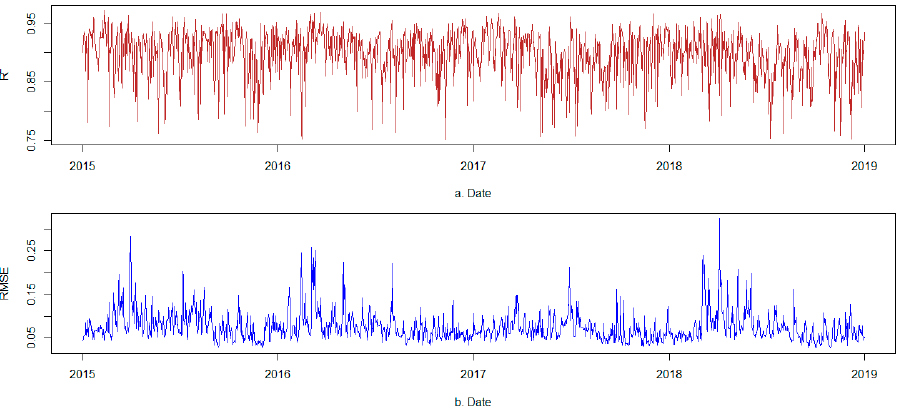
Figure 4. Time series of test R 2 ( a ) and test RMSE ( b ) for the trained daily-level imputation models. Table 4. Summary of the test performances for daily imputation models.